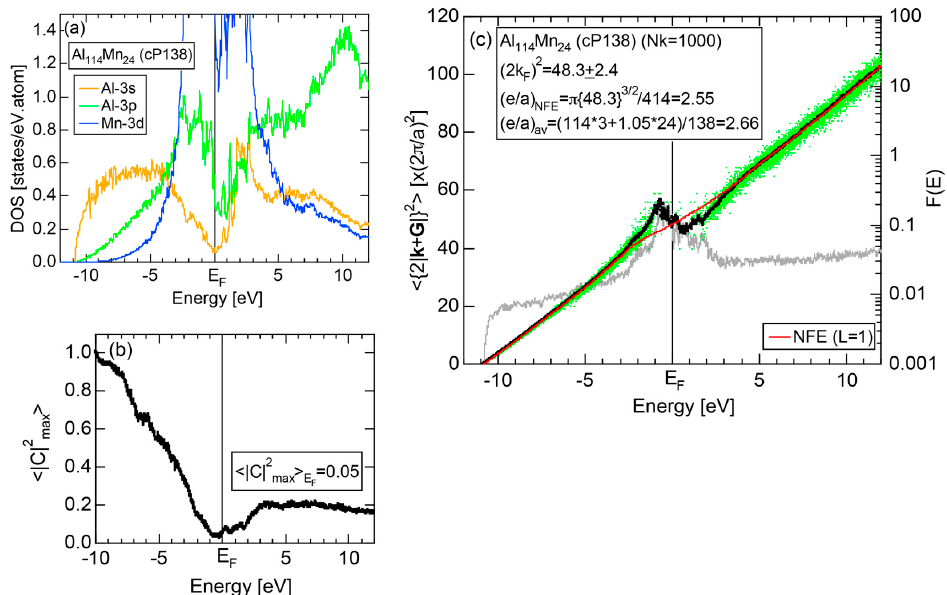
and ( c ) Hume-Rothery plot for C max2 E